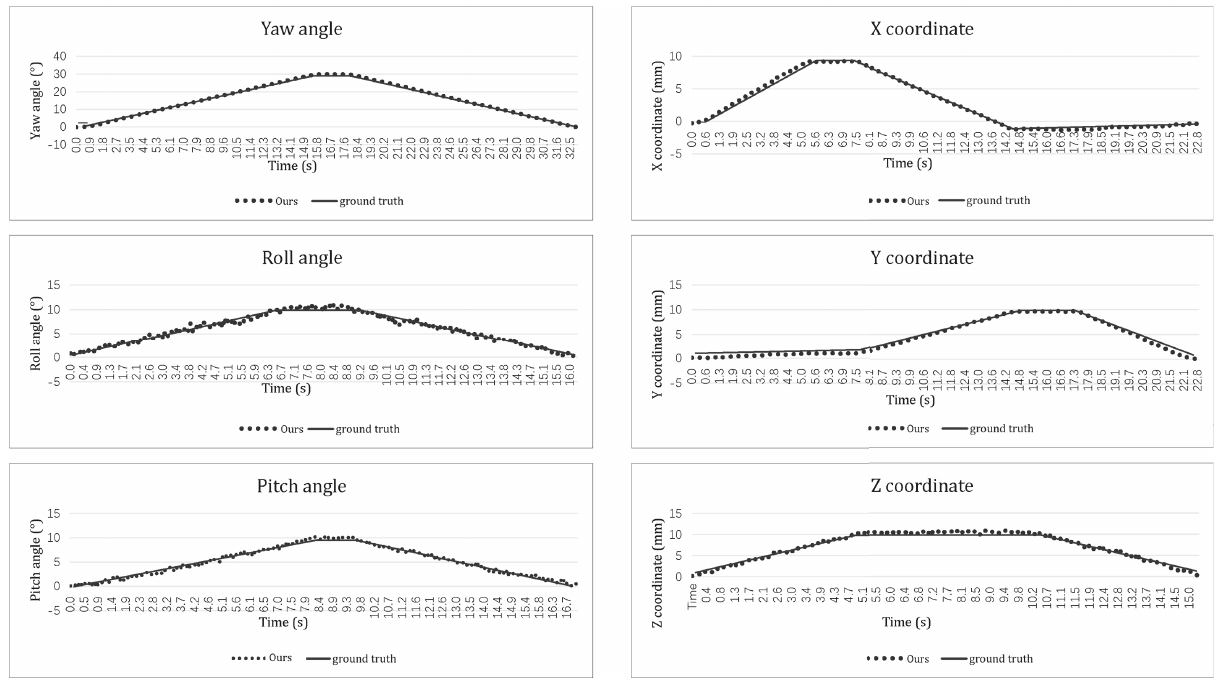
Figure 10: H-840 6-Axis Hexapod. An ultra-high precision cloud terrace with flexible control.